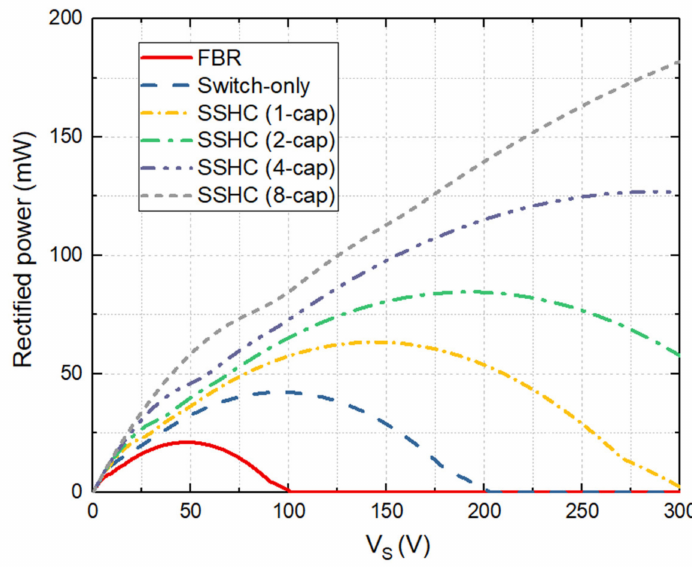
Figure 11. Simulated rectified output power using FBR, switch-only (SO) rectifier and SSHC rectifier (with di ff erent numbers of capacitor stages) for all the eight MFC elements.